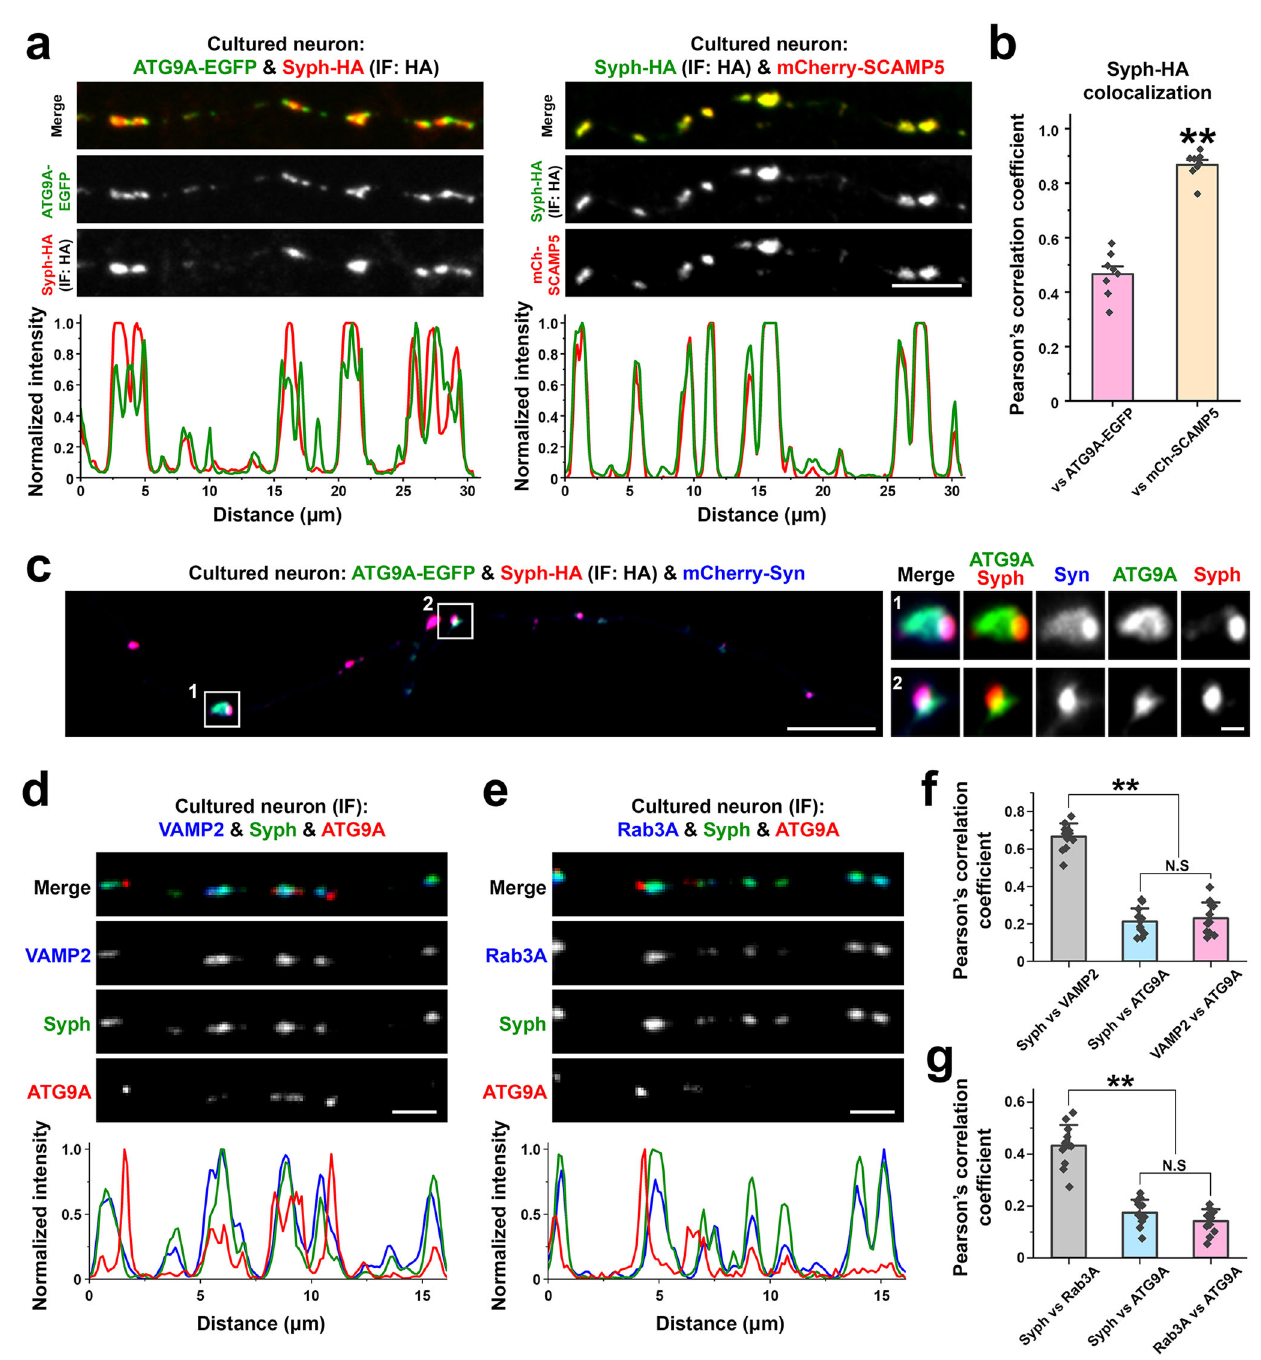
Fig. 8| ATG9A vesiclelocalization inneurons. a – c Mousehippocampalneuronal cultures were transfected as indicated and imaged at DIV14-17. a Representative confocal images (top), and corresponding line-scan analysis (bottom) of neuronal cultures expressing synaptophysin-HA with ATG9A-EGFP or mCherry-SCAMP5. Synaptophysin-HAwasdetectedbyanti-HAimmuno fl uorescence. b Colocalization analysis calculated by Pearson ’ s coef fi cients. Values are means±SEM. ** p <0.01 by the two-sided Student ’ s t -test (all boutons in 8 fi eld of view (121 μ mx121 μ m) for each condition from two independent cultures were quanti fi ed). c Localization of ATG9A-EGFP, synaptophysin-HA and mCherry-synapsin in presynaptic varicosities of an axon. Synaptophysin-HA was visualized by anti-HA immuno fl uorescence. d – g Mouse hippocampal neuronal cultures were fi xed and stained as indicated at DIV14-17 to visualize endogenous localization of ATG9A in neurons.